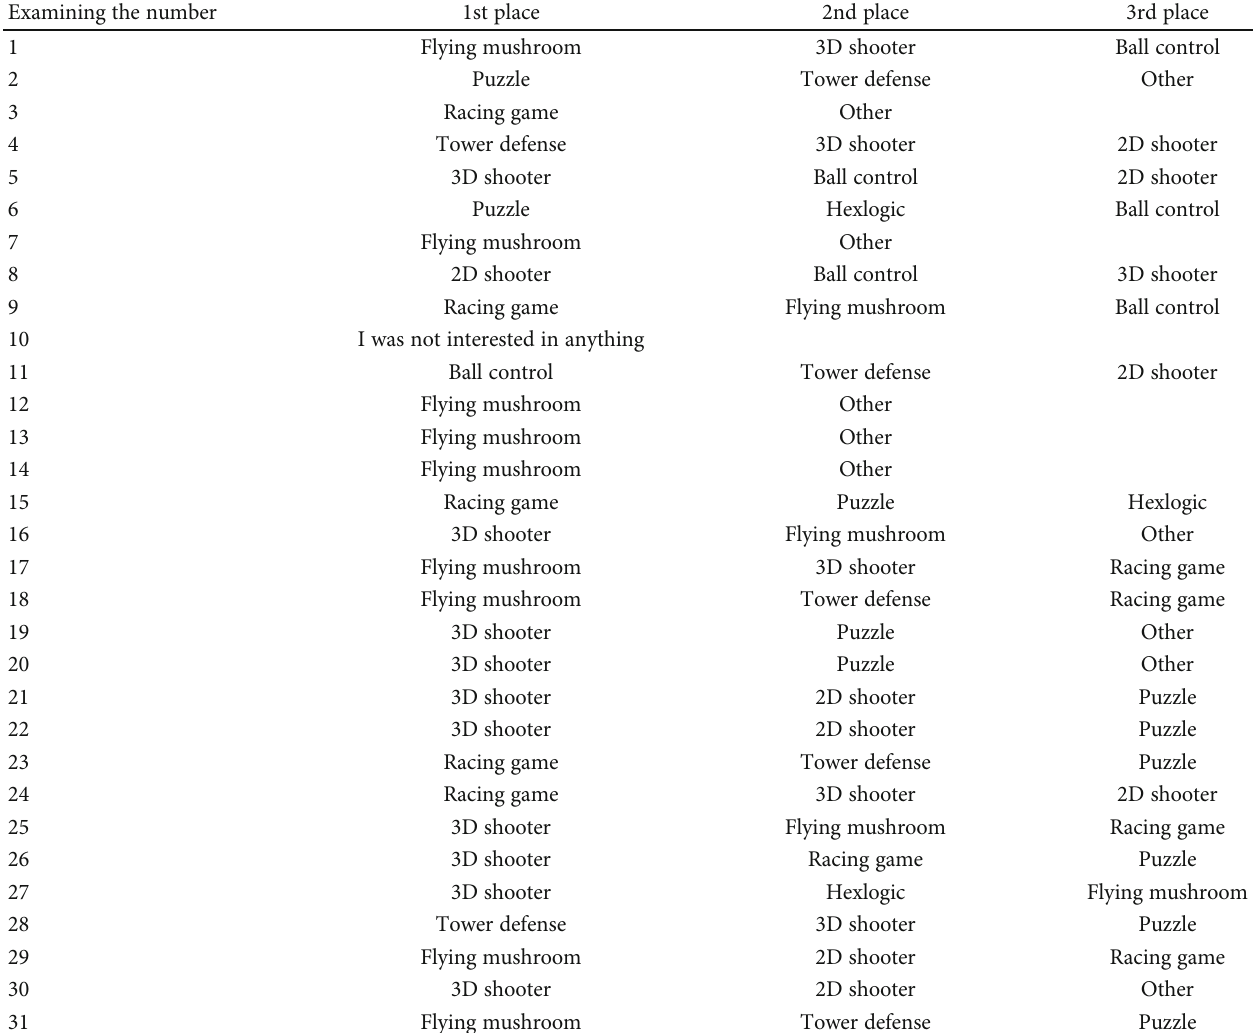
Table 3: Respondent ’ s opinion on which game he/she thinks is the